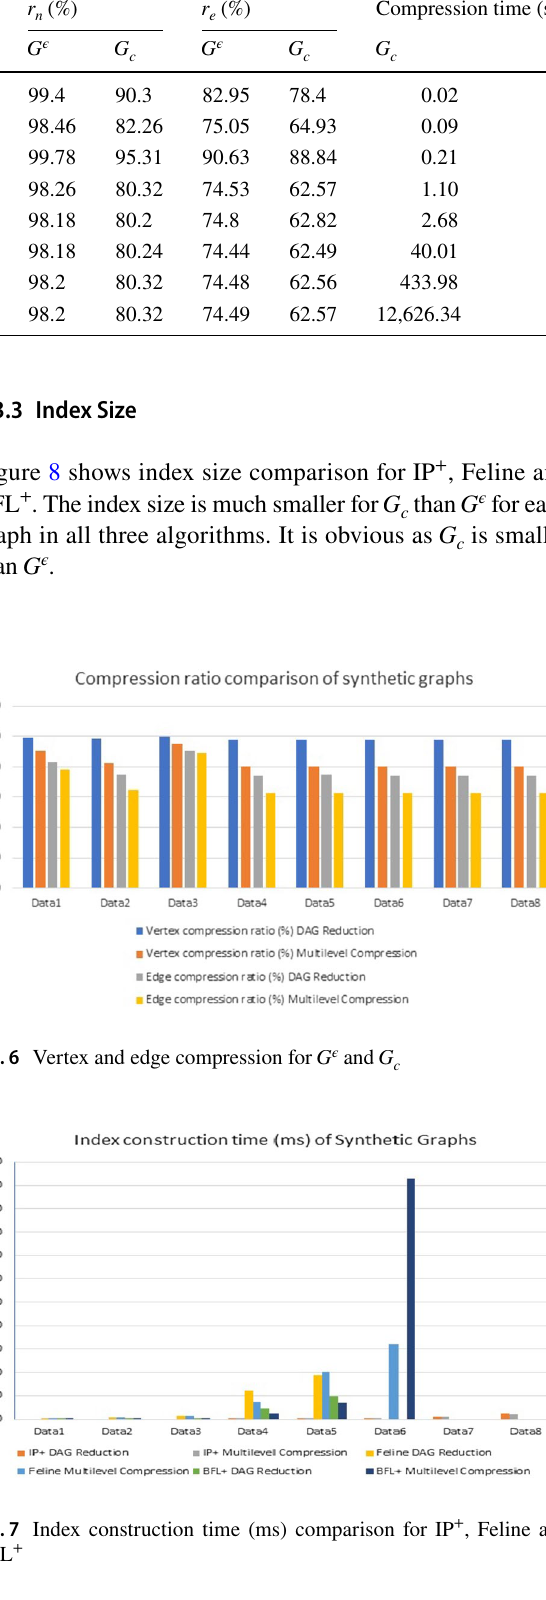
Table 8 Datasets and their compression ratio after ER reduction and multilevel compression along with the compression time for multilevel compression for synthetic datasets